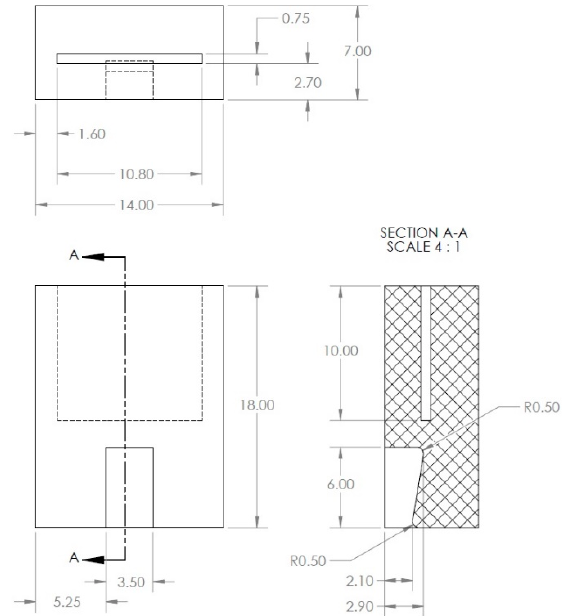
Figure 6. Plastic component dimensions.